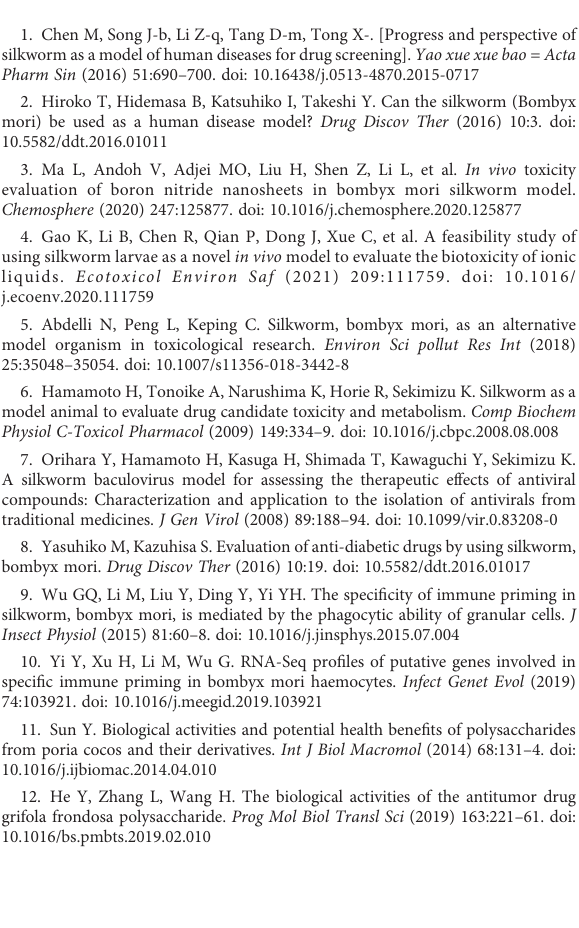
SUPPLEMENTARY FIGURE 2 Gene Set Enrichment Analysis (GSEA) enrichment plot of signi fi cantly enriched pathways related to immune response and metabolism as identi fi ed by GSEA-based Kyoto Encyclopedia of Genes and Genomes analysis. (A) MAPK signaling pathway, (B) peroxisome, (C) PI3K-Akt signaling pathway, (D) fructose and mannose metabolism, (E)